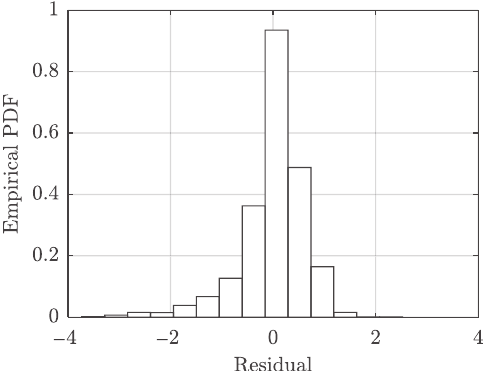
Figure 10. Model prediction residuals (in logarithm) of the developed strain rate model Equation